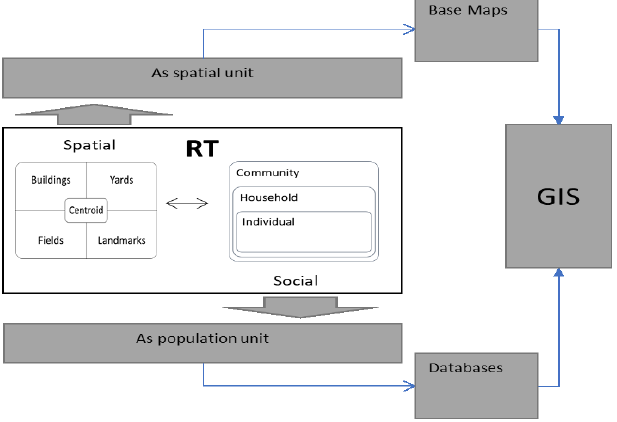
Fig. 11. Two approaches for using RT as a unit of analysis in GIS-based analysis